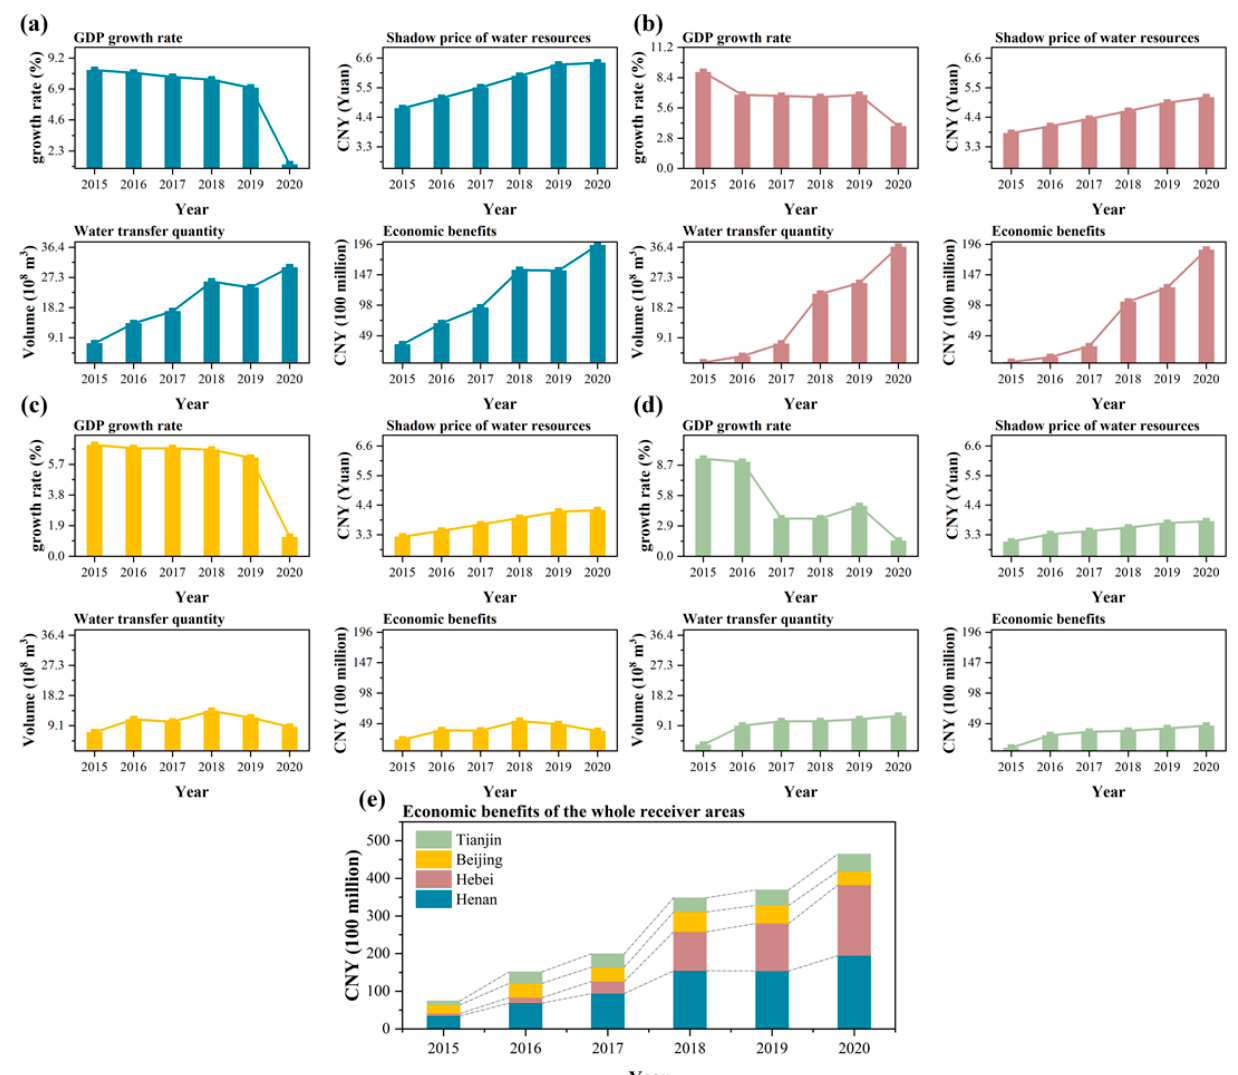
Figure 6. Economic benefits in ( a ) Henan, ( b ) Hebei, ( c ) Beijing, and ( d ) Tianjin in the receiver areas from 2015 to 2020 and ( e ) all receiver areas.